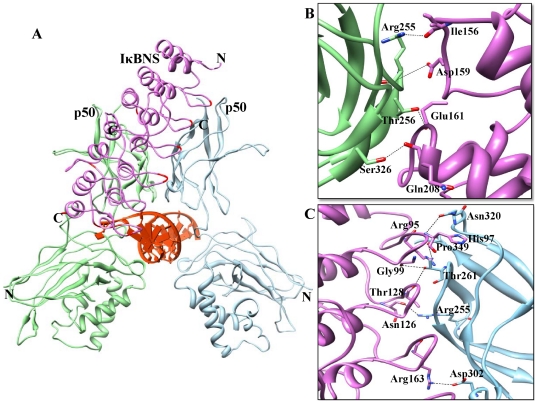
IκBNS ARD-p50/p50 homodimer interface.(A) The p50/p50 homodimers represented as a ribbon diagram are shown in light green and sky blue, respectively. Docked IκBNS is represented in orchid color in the ribbon diagram, and flexible residues involved in the interactions are red colored. (B) The p50 (chain A)-IκBNS binding interface. Side chains of the amino acids contributing to hydrogen bonding formation (marked as black dotted lines) are represented by a stick model with the residue names and numbers shown next to them. (C) The p50 (chain B)-IκBNS binding interface is also represented in a similar fashion as (B).